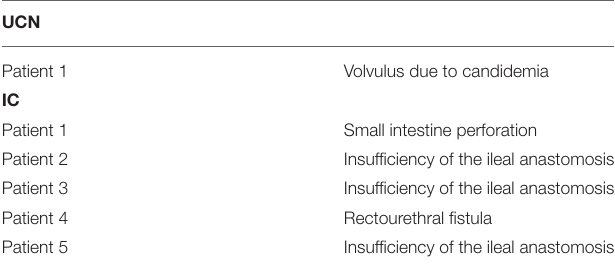
TABLE 5 | Bowel complications requiring revision in